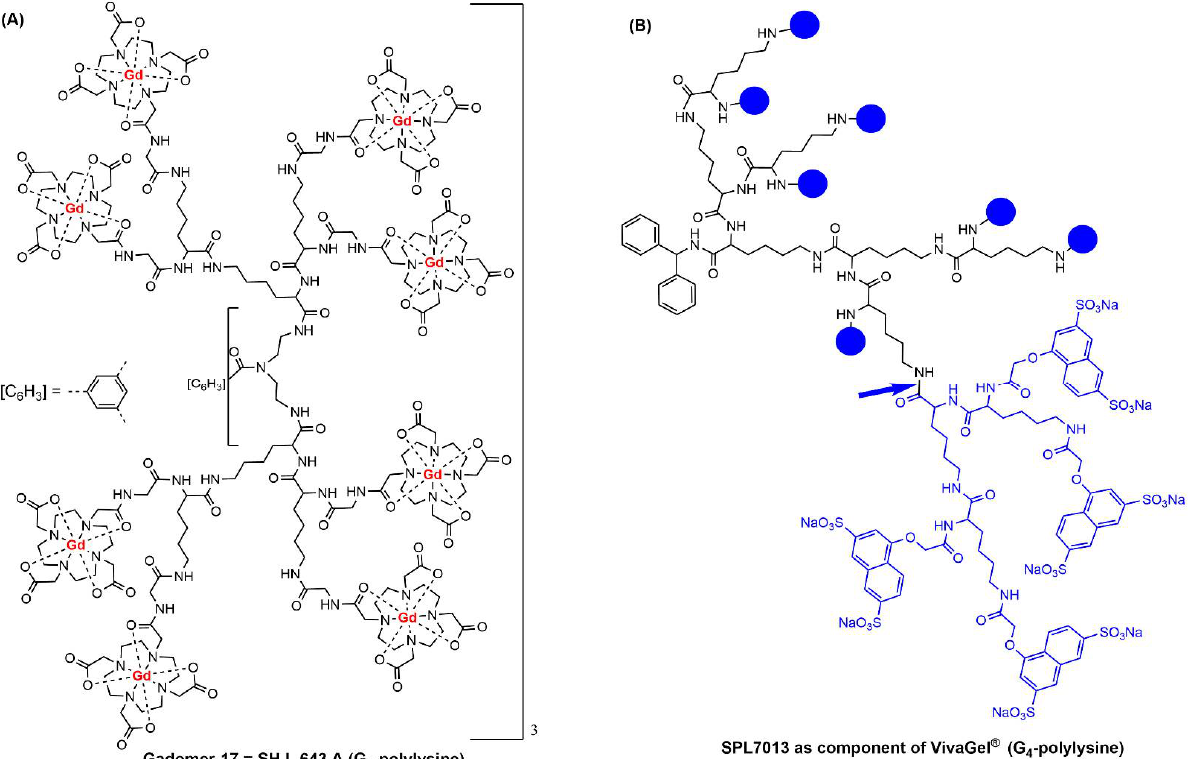
Figure 2. Chemical structure of two poly-L-Lysine dendrimers. ( A ) Gadomer-17 used as MRI agent. ( B ) SPL7013, also named Astodrimer sodium, the active ingredient in the mucoadhesive gel VivaGel ® ; the blue bowls correspond to the structure that is shown in blue after the blue arrow.